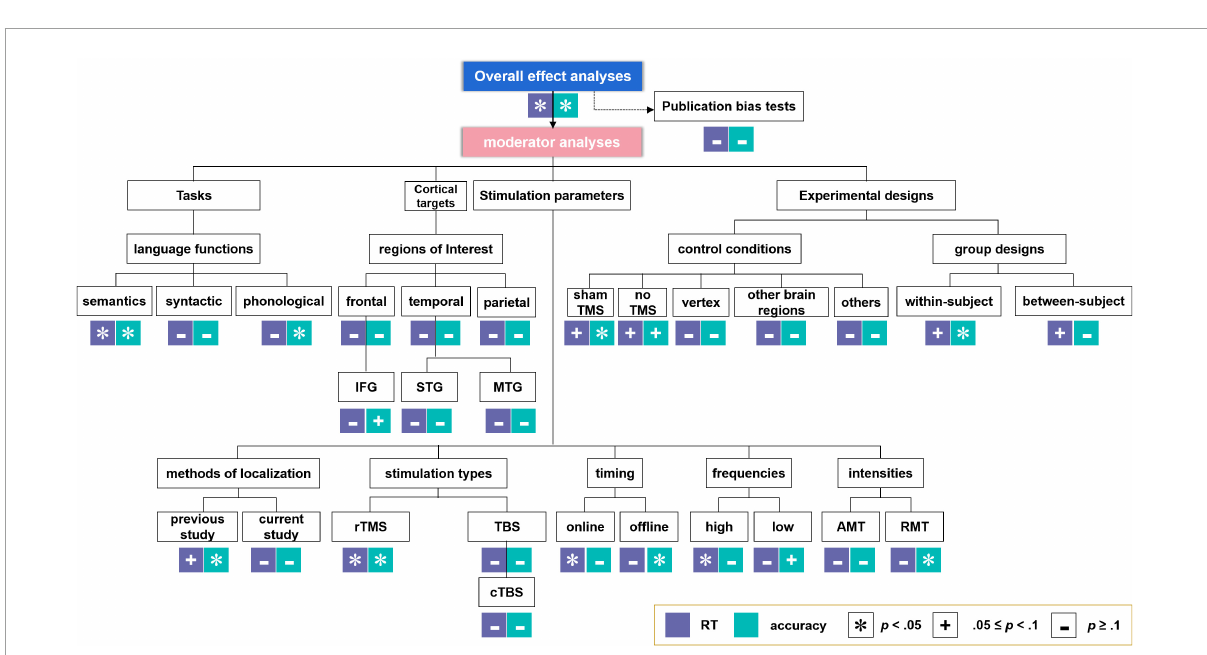
FIGURE2 Analysis-structure and results for overall effect analyses and moderator analyses. ∗ Indicates significant effects. + Indicates marginally significant effects. − Indicates non-significant